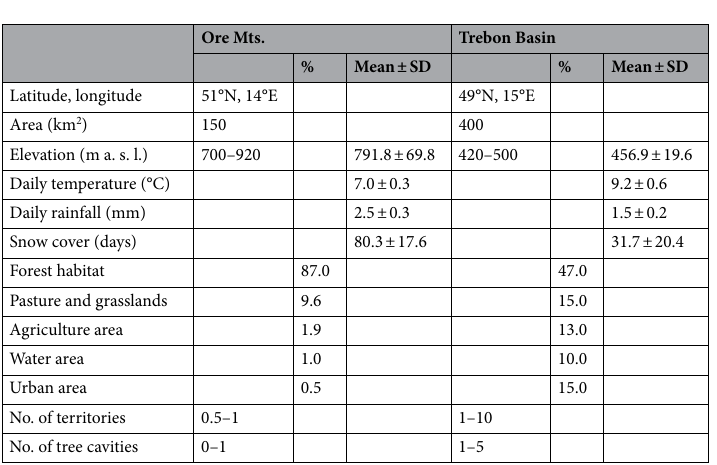
Table 2. Basic information about the study areas. Geographical position, the size of the area, elevation, climate conditions (mean daily temperature, mean daily rainfall, and the yearly mean number of days with continual snow cover), habitat composition (based on CORINE Land Cover 2018), and estimates of the number of black woodpecker’s territories (per 1 km 2 ) and tree cavities (per 1 ha) excavated by black woodpeckers are shown.